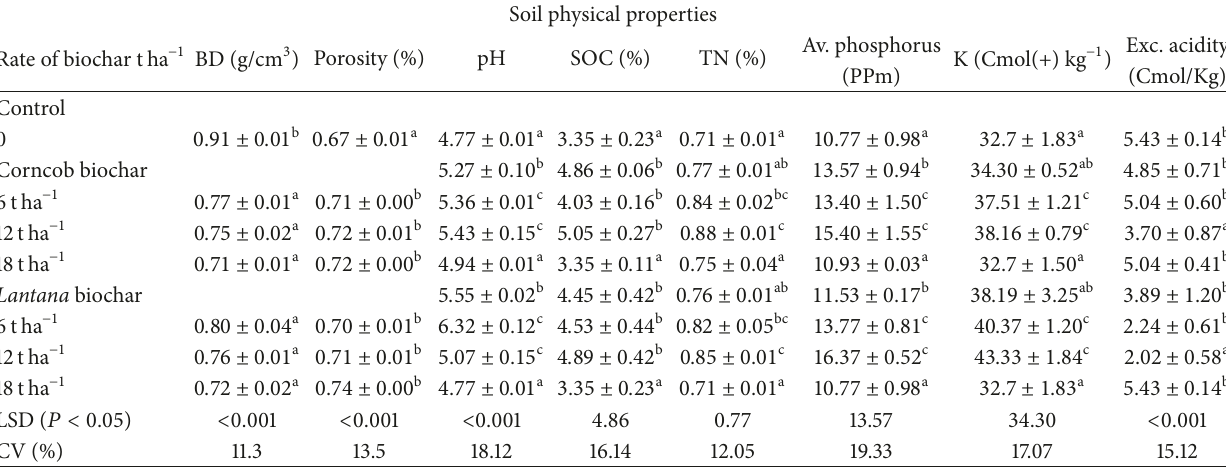
Table 2: Effect of biochar application on the soil bulk density, porosity, pH, SOC (%), TN (%), av. phosphorus, K, and exc. acidity. Soil physical properties